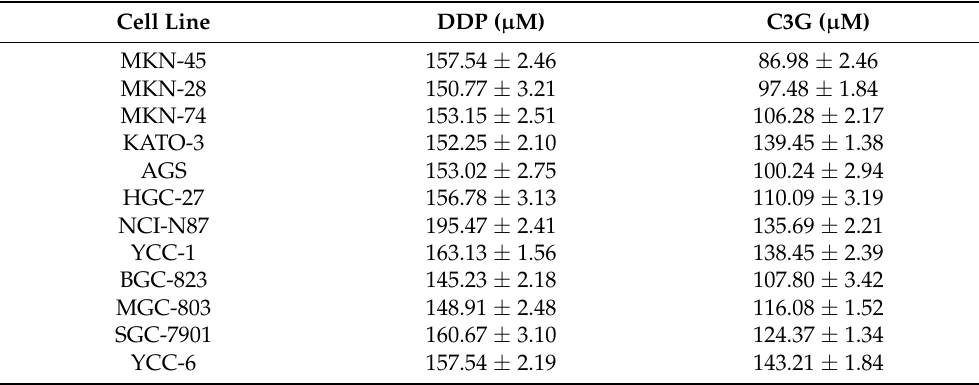
Table 1. IC 50 values of C3G and DDP in GC